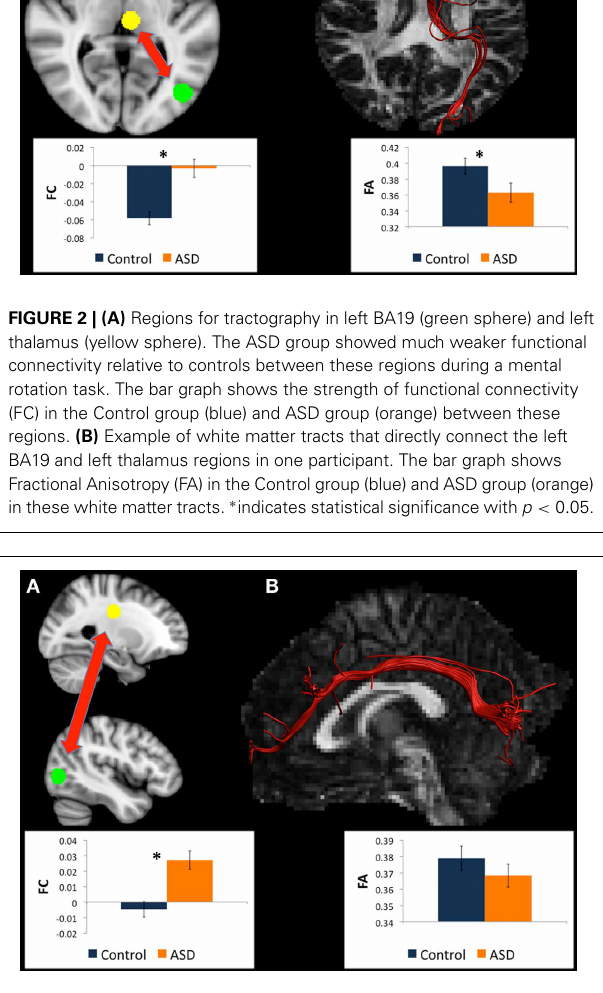
FIGURE 3 | (A) Regions for tractography in left BA19 (green sphere) and left caudate body (yellow sphere). The ASD group showed increased functional connectivity relative to controls between these regions during a mental rotation task. The bar graph shows the strength of functional connectivity (FC) in the Control group (blue) and ASD group (orange) between these regions. (B) Example of white matter tracts that directly connect the left BA19 and left caudate body regions in one participant. The bar graph shows Fractional Anisotropy (FA) in the Control group (blue) and ASD group (orange) in these white matter tracts. ∗ indicates statistical significance with p < 0 .